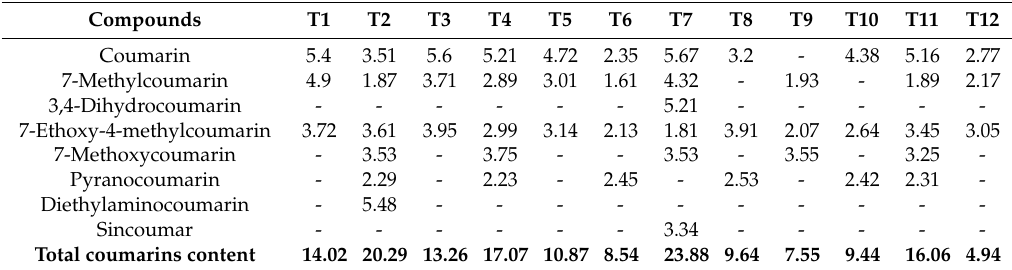
Table 4. Coumarin and its derivatives in commercial tobacco samples (mg · kg − 1 , n =